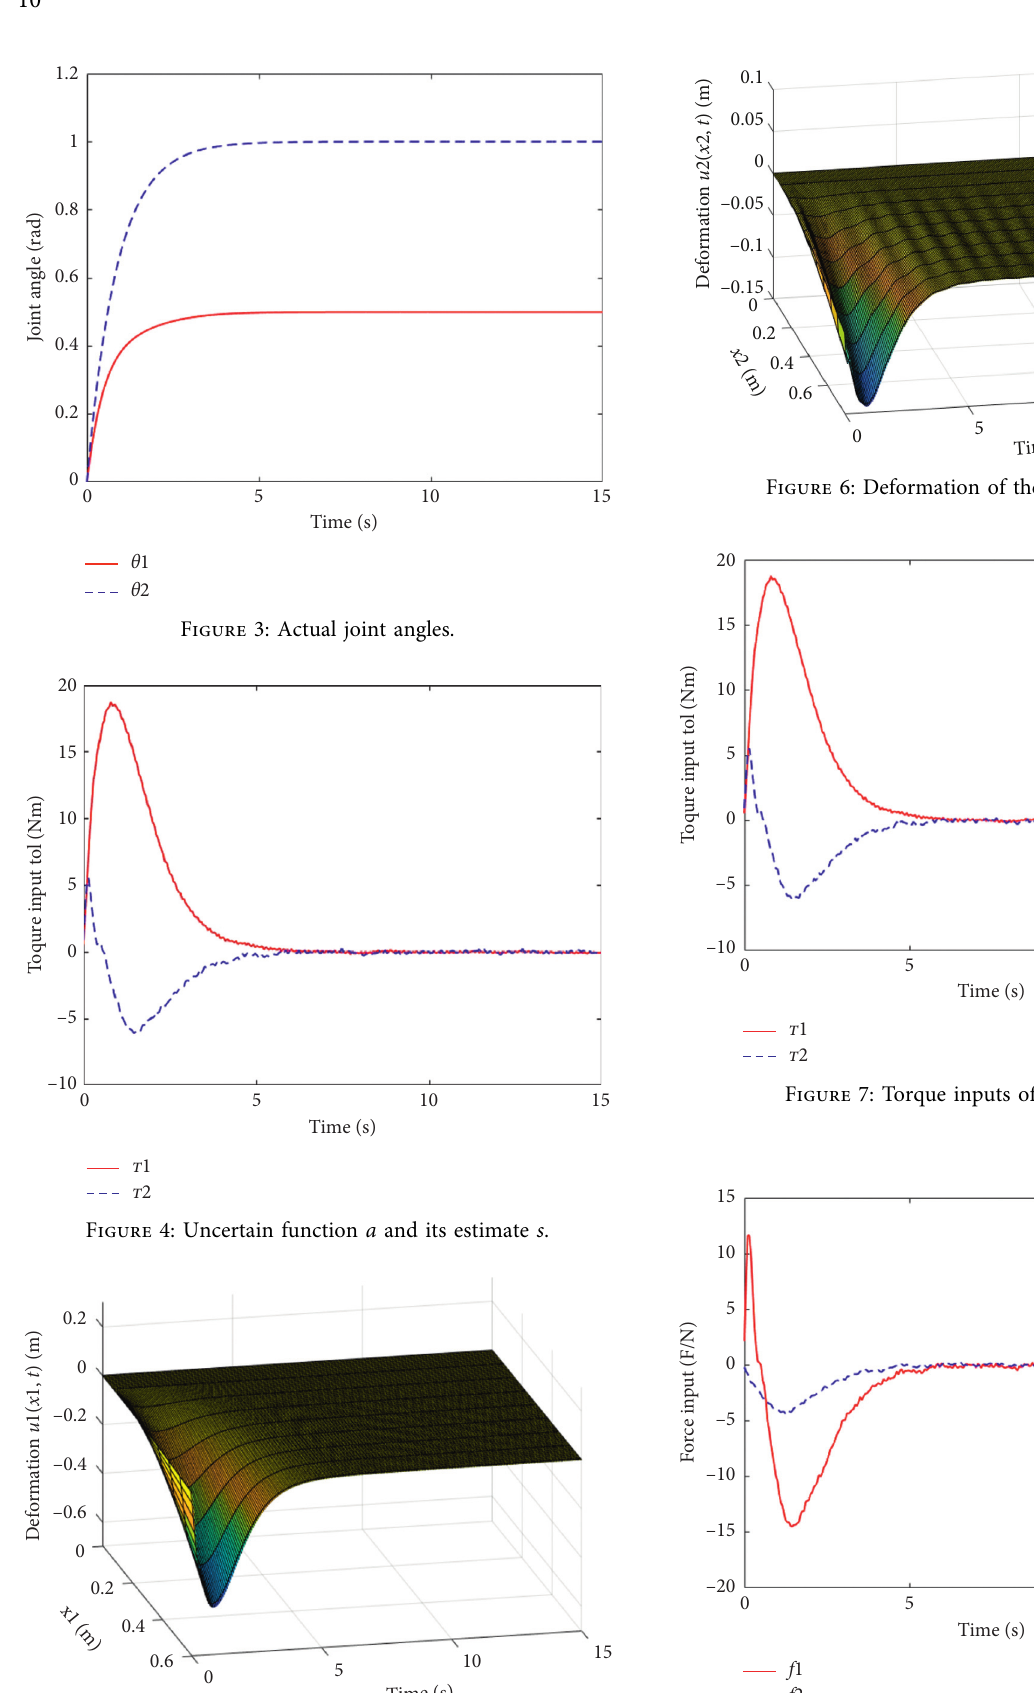
Figure 8: Force inputs of two